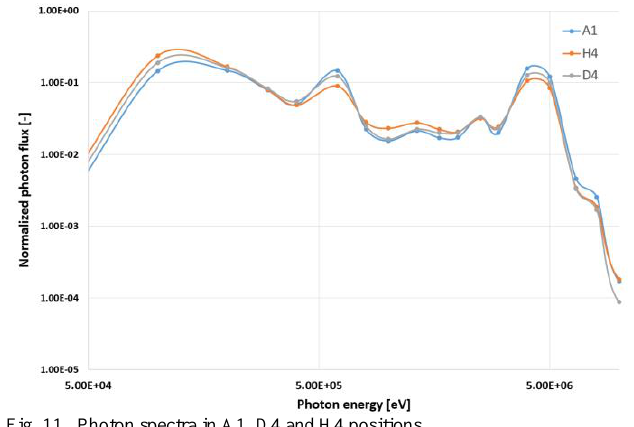
Fig. 11. Photon spectra in A1, D4 and H4 positions